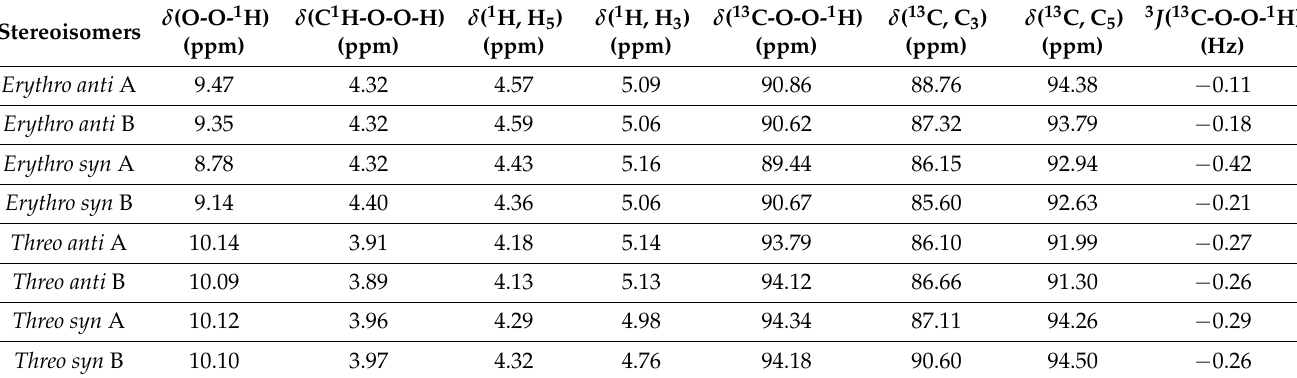
Table 10. δ (C-O-O- 1 H), δ ( 13 C-O-O-H), δ ( 13 C) of C 3 and C 5 , and 3 J ( 13 C-O-O- 1 H) coupling constants of low-energy conformers of Figure 49. Energy minimization was performed at the DFT/B3LYL/6- 31+G(d) level and calculation of NMR parameters at the GIAO/B3LYP/6-311+G(2d,p) CPCM (CHCl 3 ) level [141].